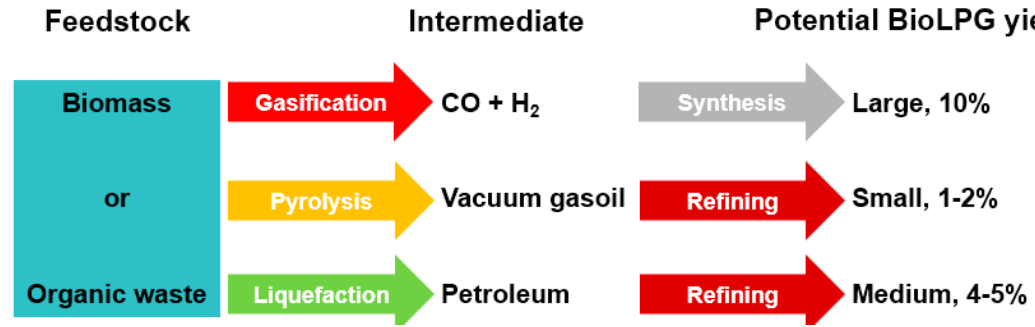
Figure 5. Advanced chemical paths to BioLPG.